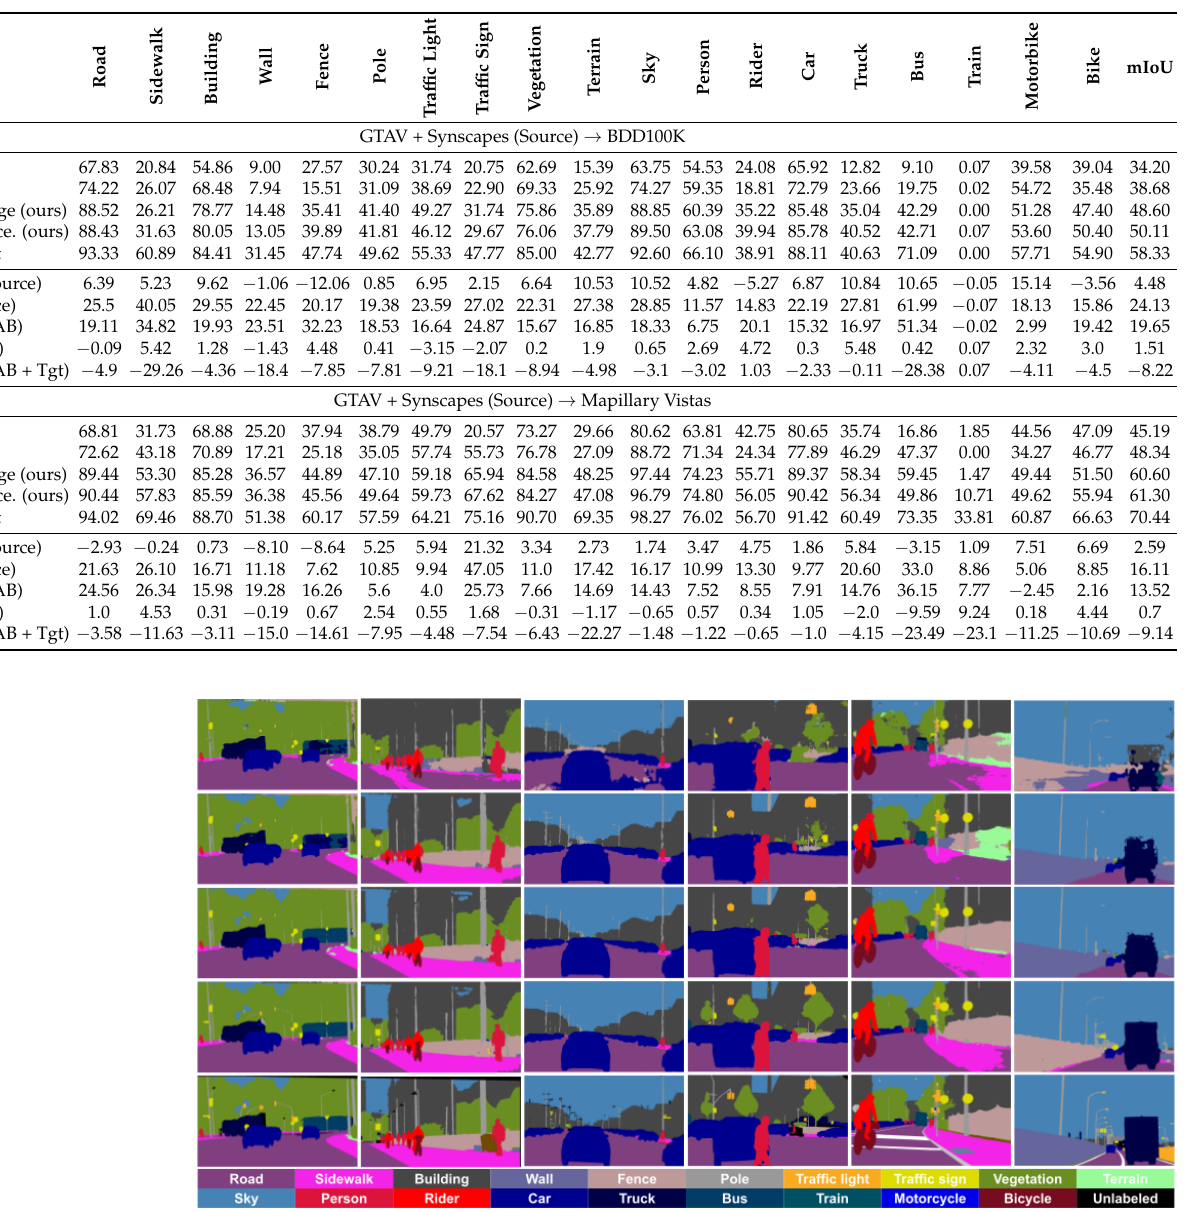
Figure 2. Qualitative results using GTAV + Synscapes as source domain. From ( left ) to ( right ), the two first columns correspond to Cityscapes in the role of the target domain, the next two columns to BDD100K, and the last two to Mapillary Vistas. ( Top ) to ( bottom ) rows correspond to SrcLAB, self-training stage, full co-training procedure, upper bound, and ground truth,